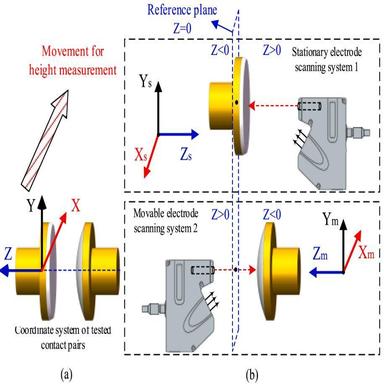
Test settings before the experiment. (a) Coordinate system of test rig at the switching position. (b) Coordinate systems of scanners at the 3D measurement position.